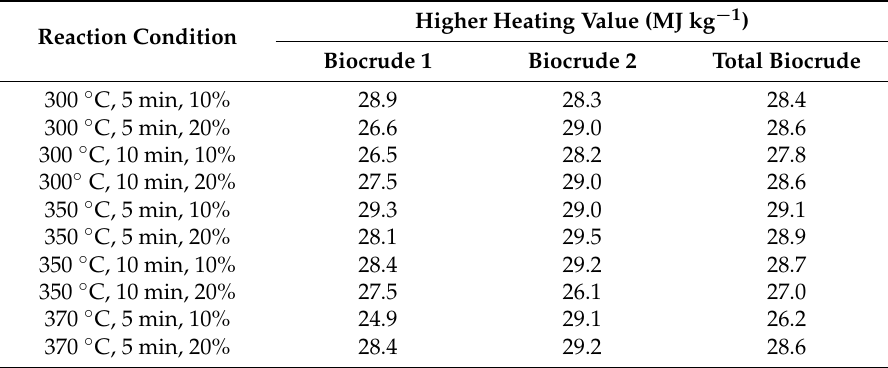
Table A6. Higher heating value of the biocrude samples.